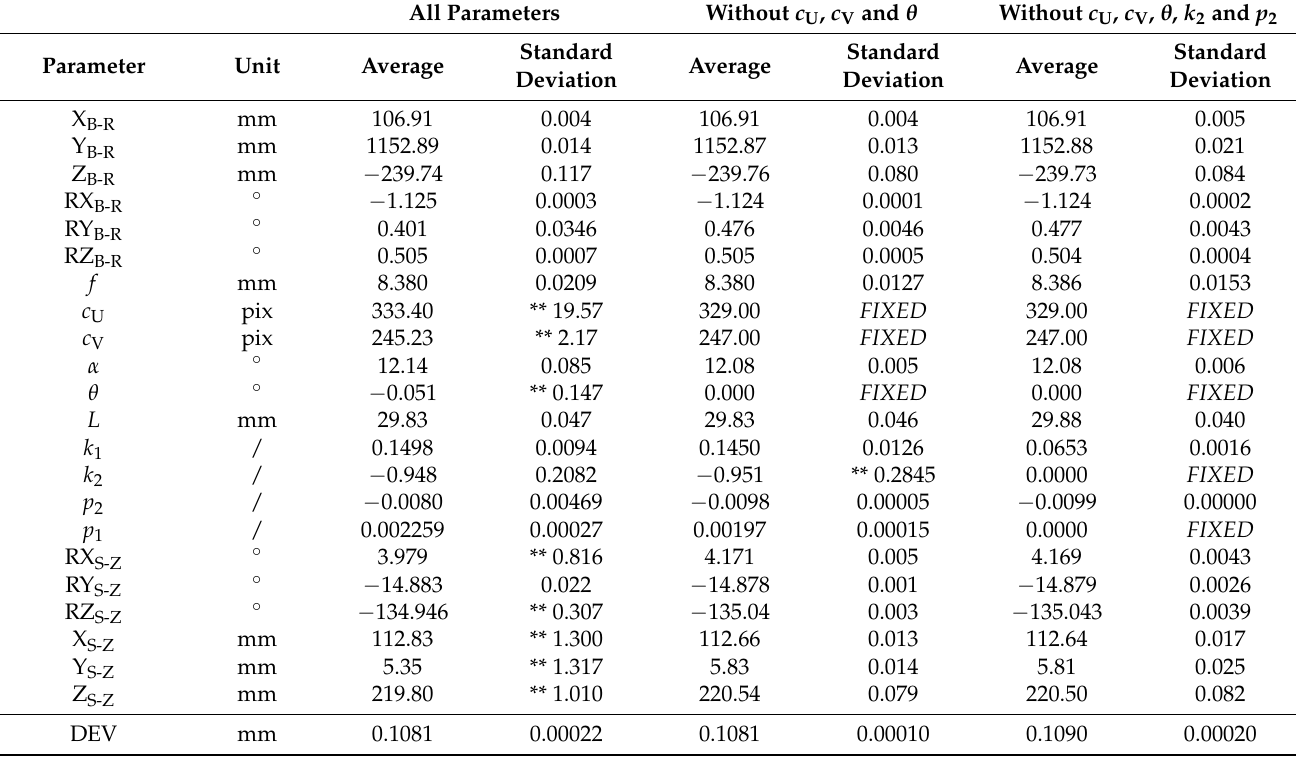
Table 1. Average values of optimized transformation parameters and respective standard deviations for N = 8 repeated optimizations of the same measurement set where initial values of hand–eye parameters were randomly varied. Excessive standard deviations are marked with **, and parameters that were not optimized in the second and third scenarios are marked with FIXED